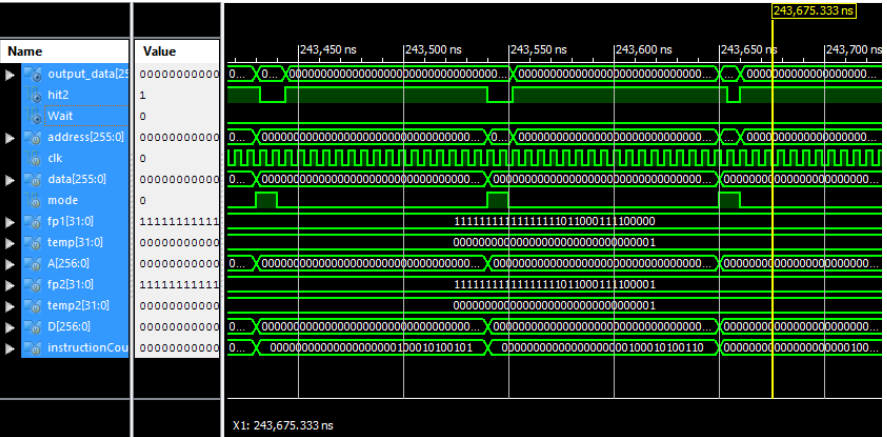
Figure 15. Delay cycle when a cache hit or miss